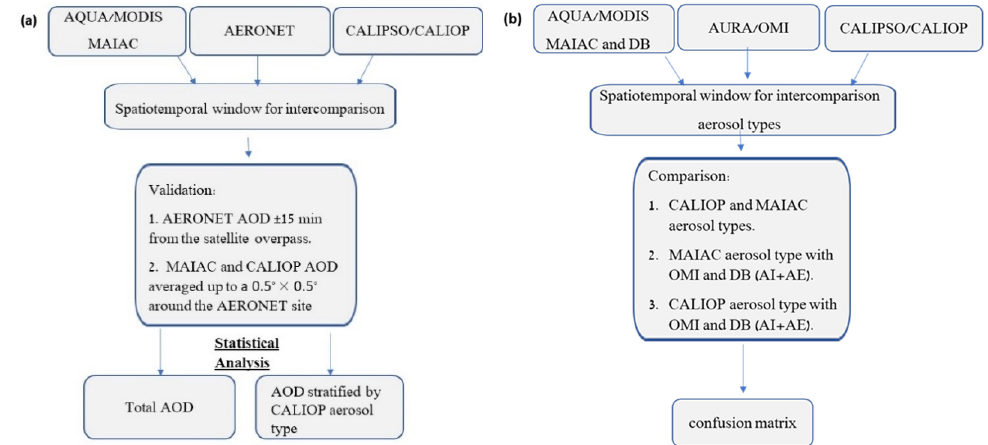
Figure 2. Flowchart of the performance evaluation of MAIAC and CALIOP AOD retrieval ( a ) and aerosol type estimation ( b ).